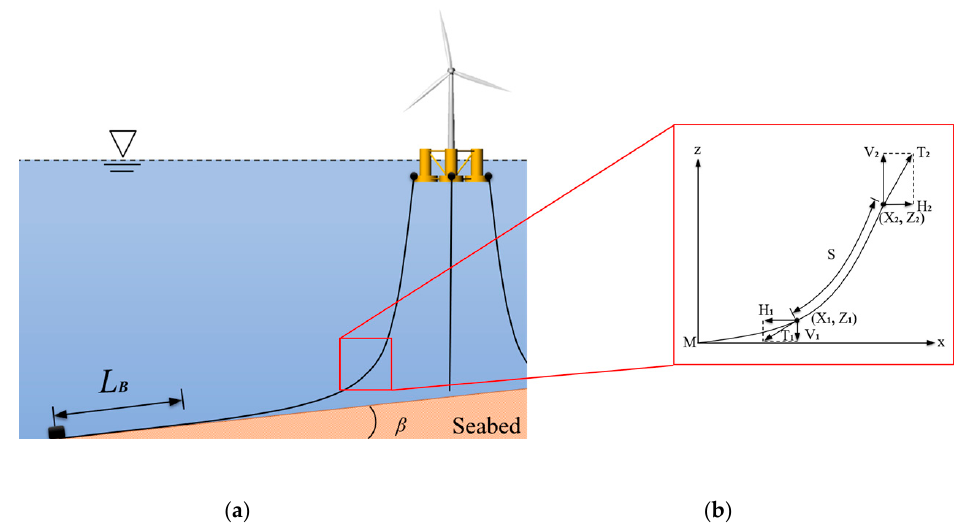
Figure 3. Description of the quasi-static mooring model: ( a ) the schematic diagram of quasi-static model; ( b ) the catenary solution of each quasi-static mooring line. L B means the length of the un-stretched mooring cable on the seabed; β is the slope of seabed; and S is the un-stretched length of a catenary segment from its top right end ( X 2 , Z 2 ) .